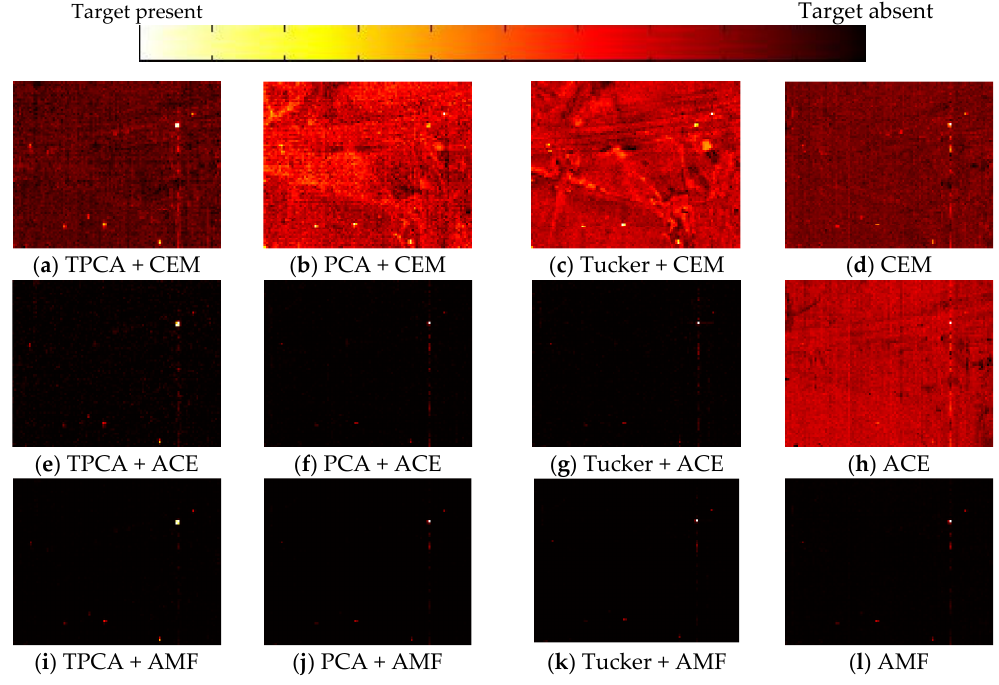
Figure 12. Detection results of the HYDICE dataset with different feature extraction methods and traditional TD methods.